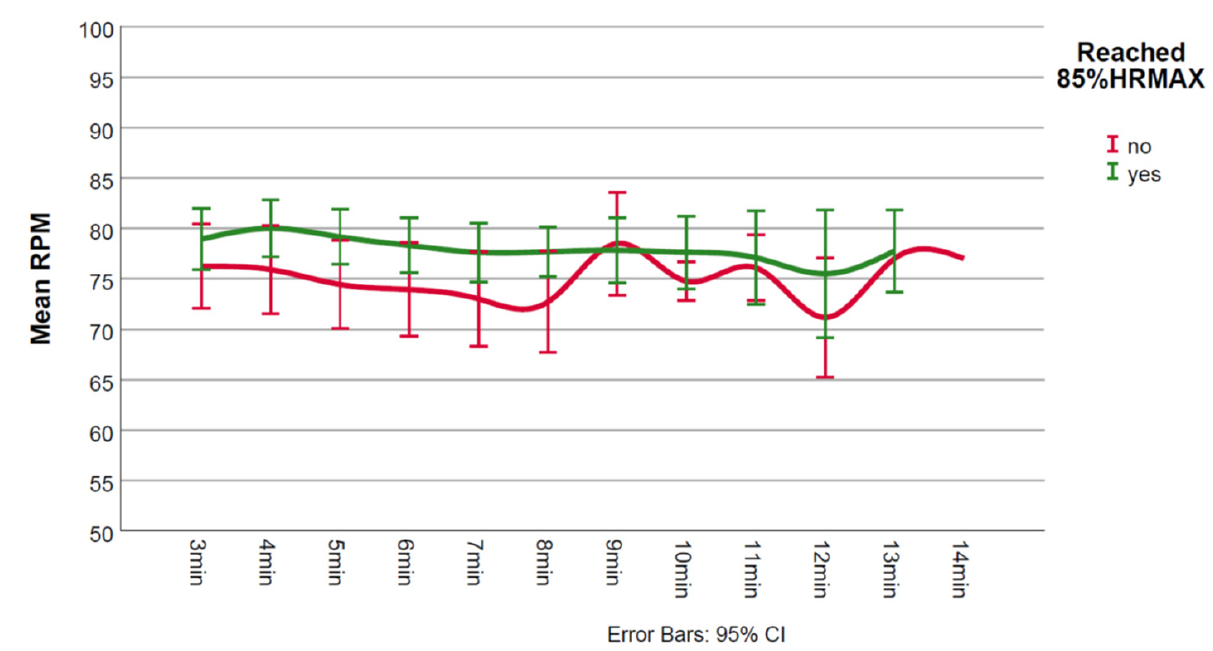
Figure 3. Mean revolutions per minute (rpm) values for achievers and non-achievers.